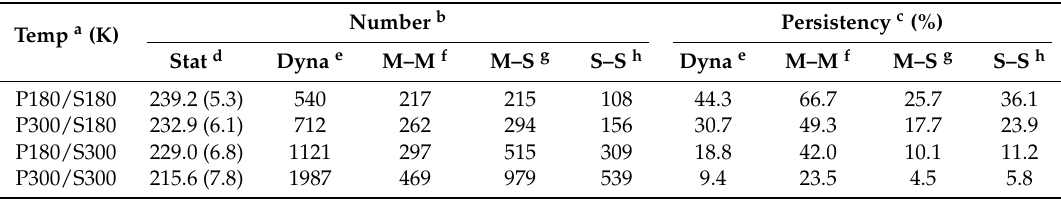
Table 2. Properties of HBs within proteinase K calculated from the joined MD trajectories at the four combined temperatures.